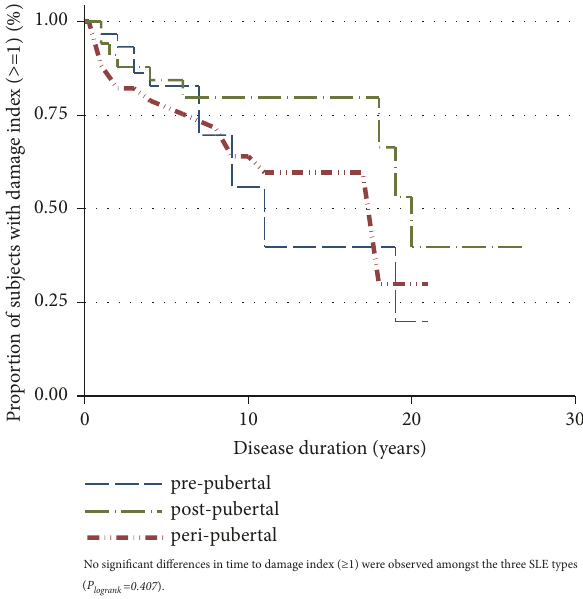
Figure 1: Kaplan-Meir plot of time to damage (index ≥ 1) stratified by age at disease onset. No significant differences in time to damage index ( ≥ 1) were observed among the three SLE types ( P =0.407 logrank